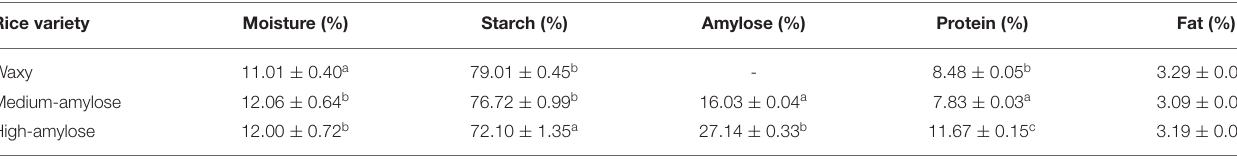
TABLE 1 | Chemical compositions of raw black rice with different amylose contents † .